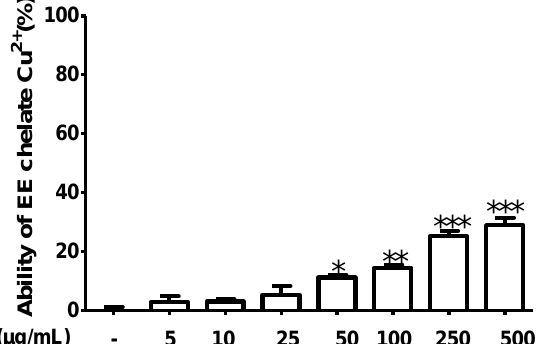
Figure 2. E ff ect of the ethanol extract of C. cyrtophyllum leaves (EE) on Cu 2 + chelation ability. Figure 2. Effect of the ethanol extract of C. cyrtophyllum leaves (EE) on Cu 2+ chelation ability. Each Each bar represents the mean ± S.E. for three di ff erent experiments performed in triplicate. * p < 0.05, bar represents the mean ± S.E. for three different experiments performed in triplicate. * p < 0.05, ** and ** and *** p < 0.001 compared to the control *** p < 0.001 compared to the control group.